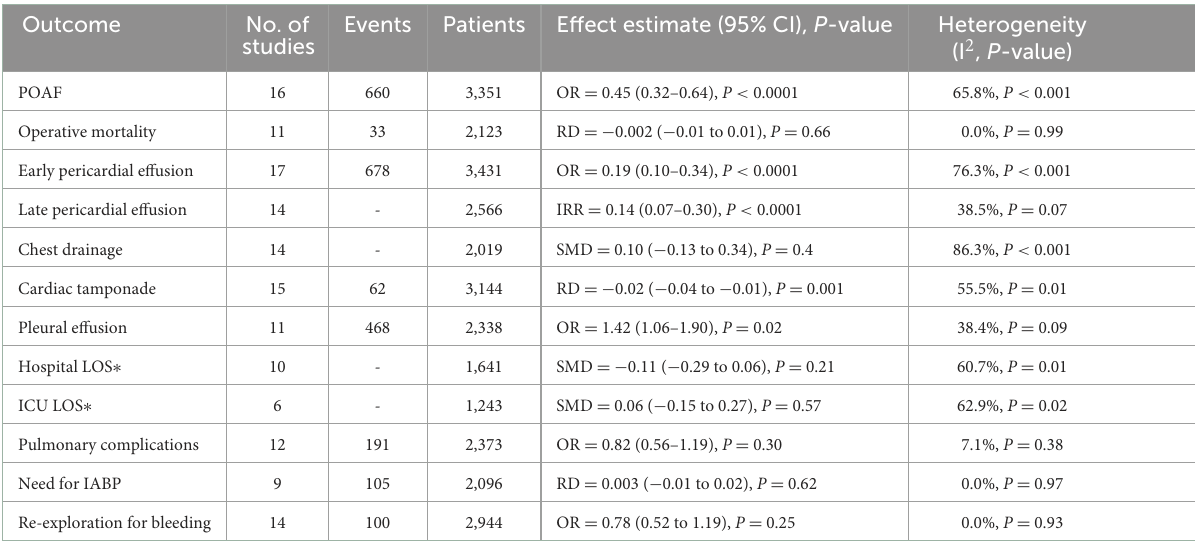
TABLE 2 Summary of the primary and key secondary